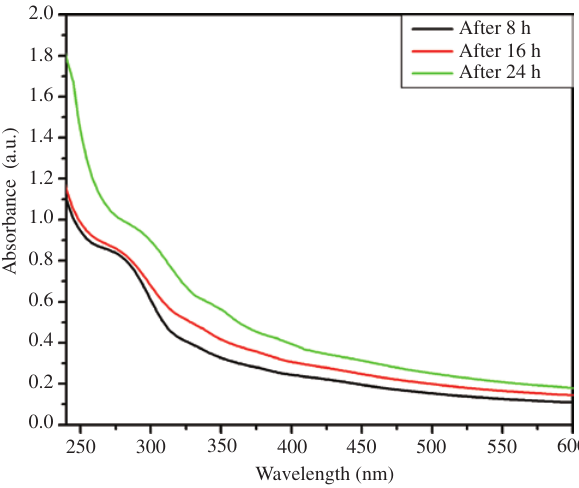
Figure 1: UV-visible spectrum of zinc sulfide nanoparticles synthe- sized using Chlamydomonas reinhardtii cell free extract at room temperature over the course of 24